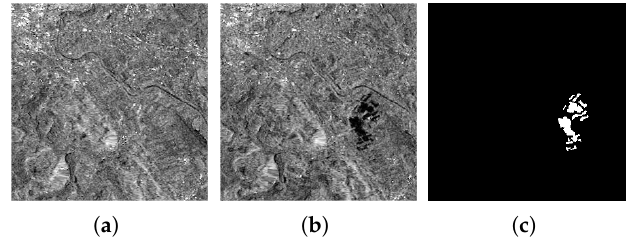
Figure 8. Bern dataset. ( a ) X 1 ; ( b ) X 2 ; ( c ) ground truth.